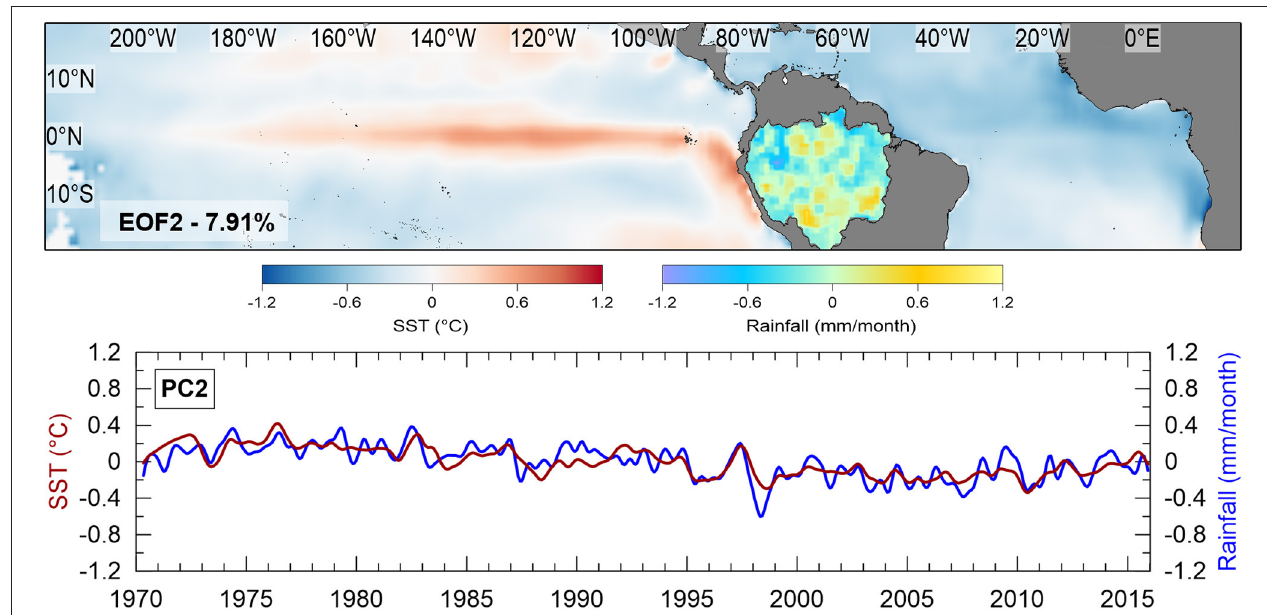
FIGURE 2 | Second EOF of 4 month-lagged covariance matrix between SST and rainfall (normalized scale by 10 3 ), the Squared Covariance Fraction (SCF) in percentage, and the second Principal Component (PC2).